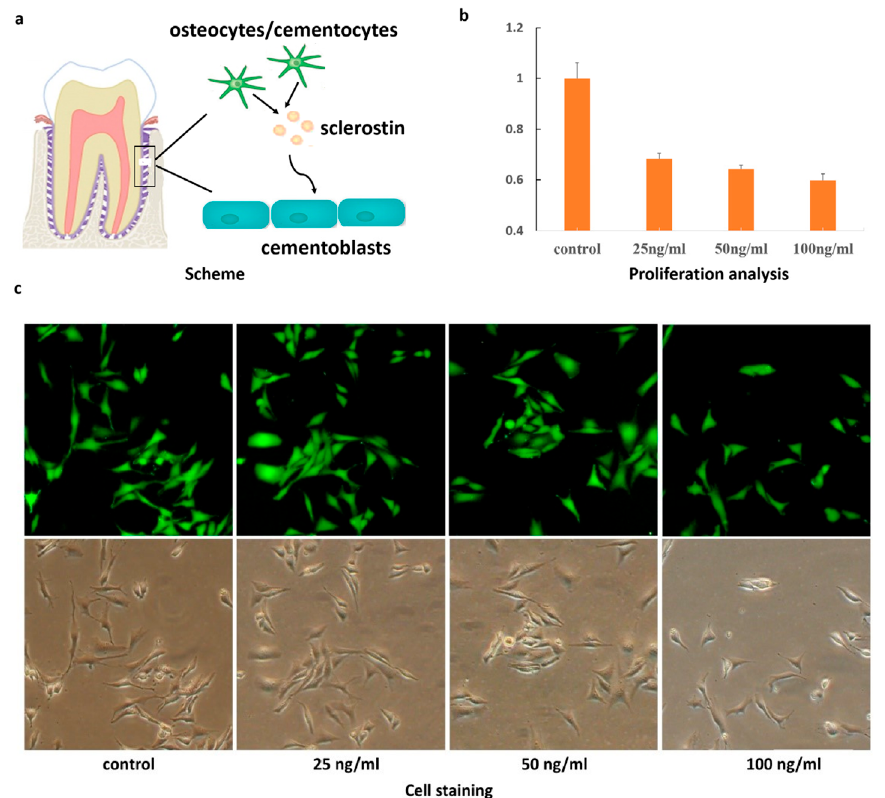
Figure 1. ( a ) Schematic illustration of the effect on cementoblasts through use of sclerostin secreted by osteocytes; ( b ) Proliferation analysis of cementoblasts in the presence of sclerostin; ( c ) Live-cell staining treated by sclerostin with different concentrations.